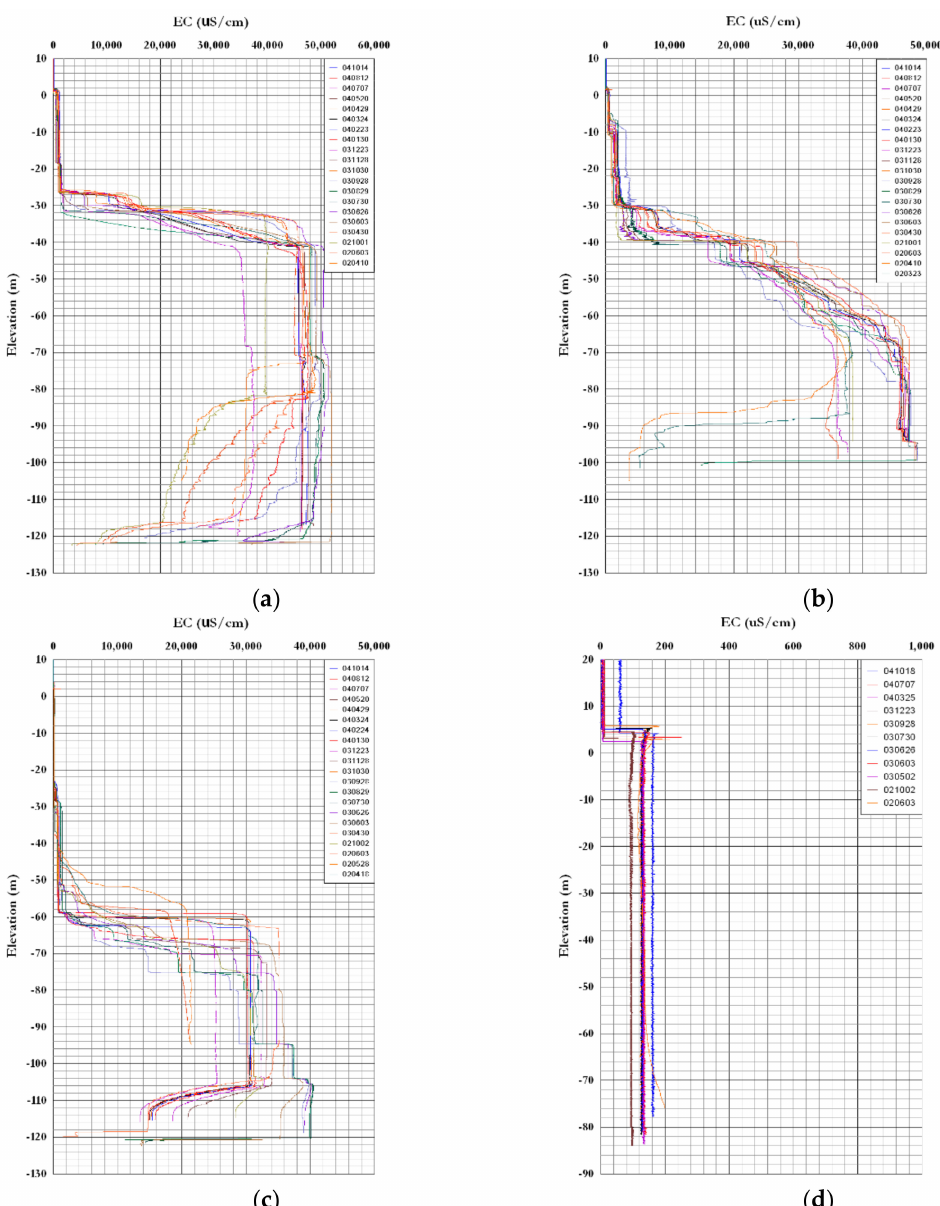
Figure 9. Periodic electrical conductivity logs from 2002 to 2004 (Institute of Environmental Resource Research, Jeju Special Self-Governing Province). Boreholes ( a ) SS-1; ( b ) SS-2; ( c ) SS-3; and ( d )